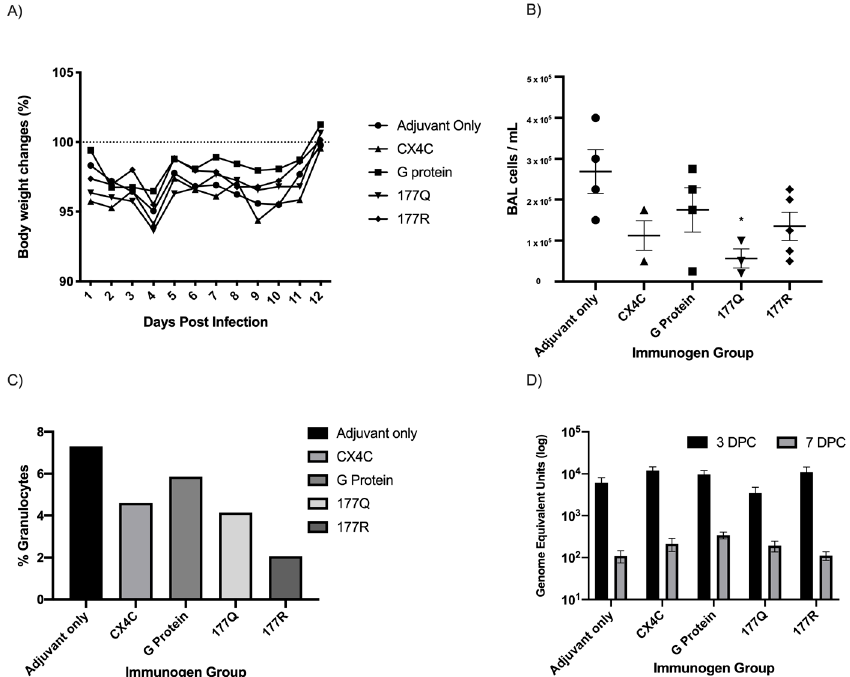
Figure 8. Disease markers in challenged mice. Mice were vaccinated with G protein immunogens and challenged with 10 6 PFU RSV/A2. ( A ) Mice were weighed daily from days 0–12 post-challenge. Each shape represents the mean weight change from starting weight in each group each day. ( B ) Pulmonary leuokcyte infiltrates were collected seven days post-challenge. Graph indicates the mean BAL cells/mL + SEM. * p < 0.05 by one-way ANOVA compared to adjuvant-only group. ( C ) BAL cells were pooled and analyzed by flow cytometry. Percent granulocytes were determined using SSC hi singlets. Twenty-thousand events were collected on LSR-II. ( D ) Lungs of challenged mice were collected on days 3 and 7 post-challenge and evaluated for RSV M protein transcripts by qRT-PCR. Data represent the mean of triplicate experiments. Standard curve was generated with a known concentration of RSV/A2 and two-way ANOVA was performed.